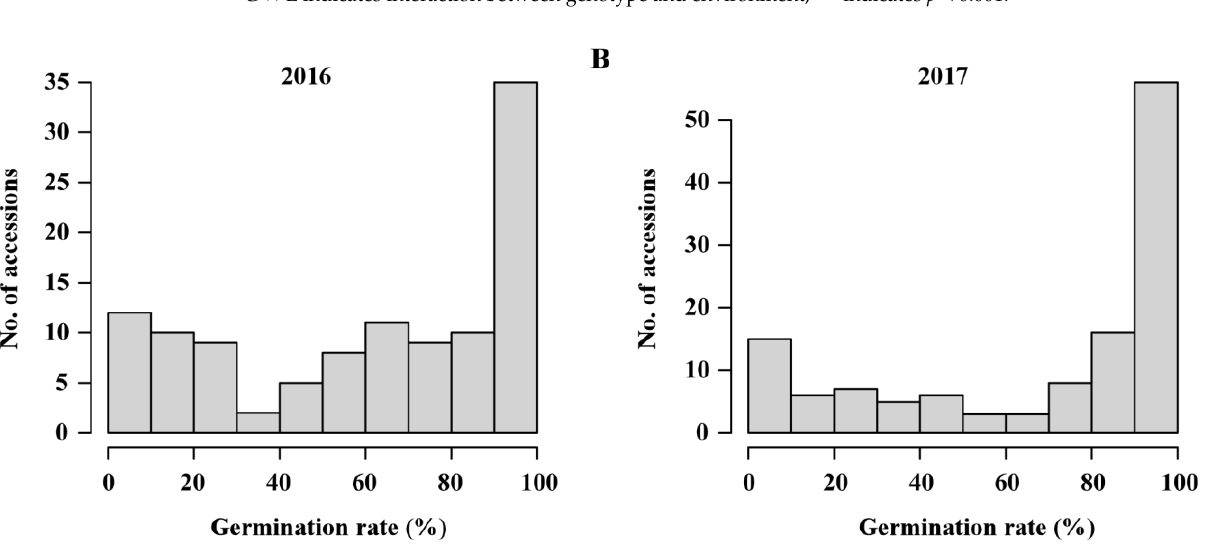
Figure 1. Natural variation for seed germination in Japonica rice. The distribution of germination rate at three days after imbibition in 2016 ( A ) and 2017 ( B ).